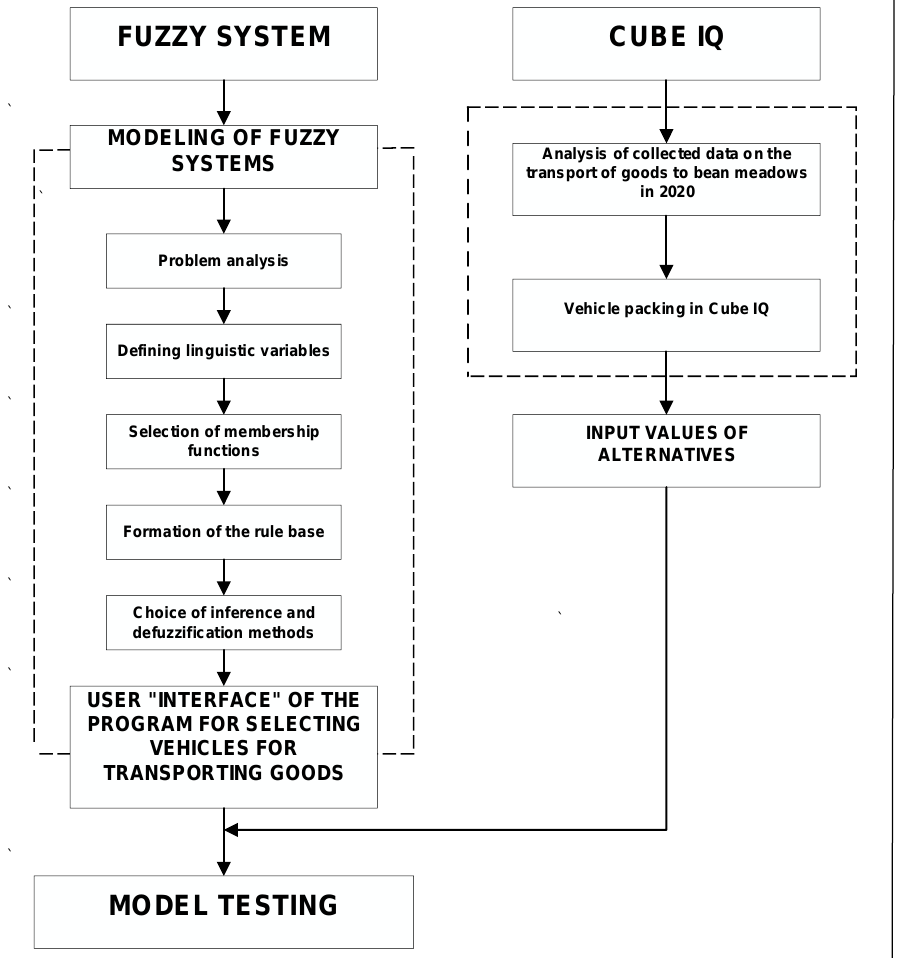
Figure 4 – Scheme of the model for the optimization of vehicle selection Рис. 4 – Схема модели оптимизации выбора транспортных средств Слика 4 – Шема модела за оптимизацију избора